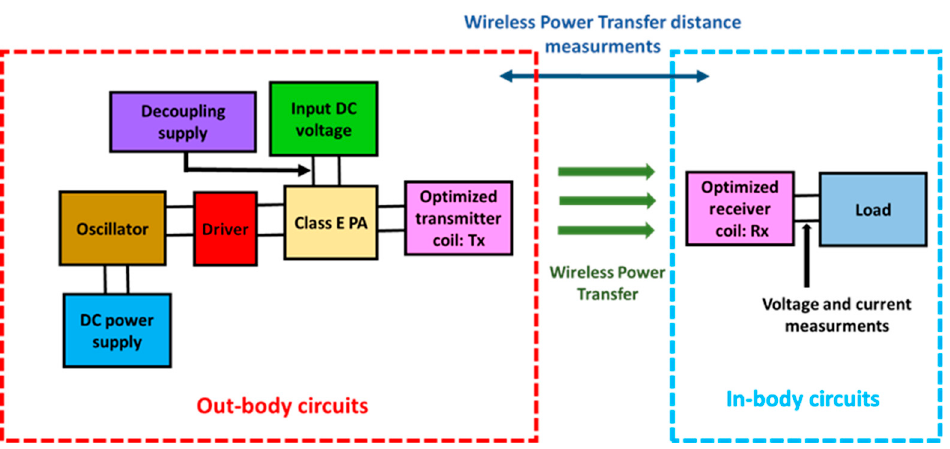
Figure 13. Block diagram of the proposed near-field RIC WPT system. Energies 2019 , 12 , x FOR PEER REVIEW